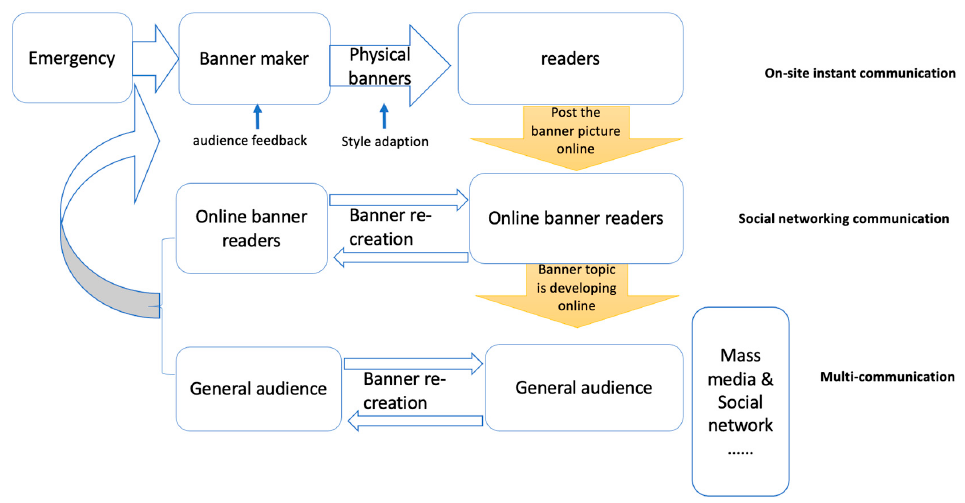
Figure 3. Circulation mode diagram of Early COVID-19 banners.